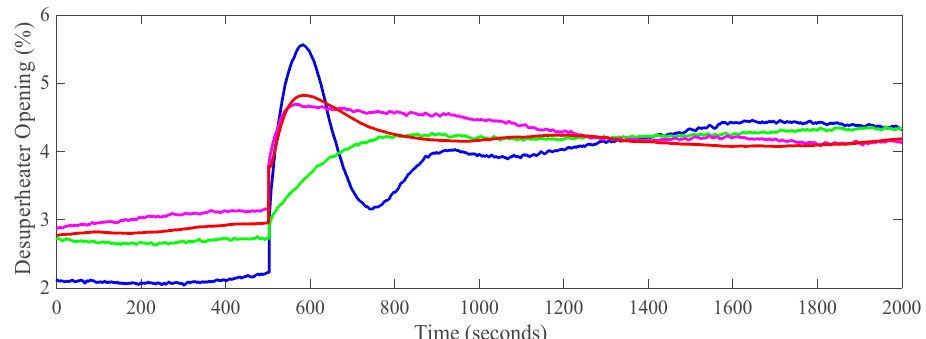
Figure 21. Experimental results of tracking on the power plant simulator. (Set point: — , PI sim -PI: — , PI i -PI: — , ADRC-PI: — , Hybrid ADRC: — ).